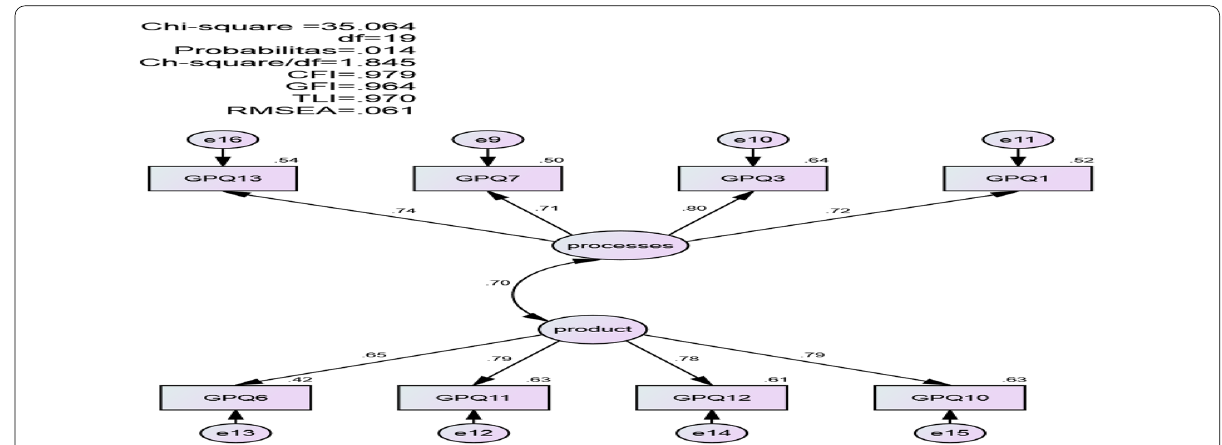
Fig. 1 The hypothesised model of green